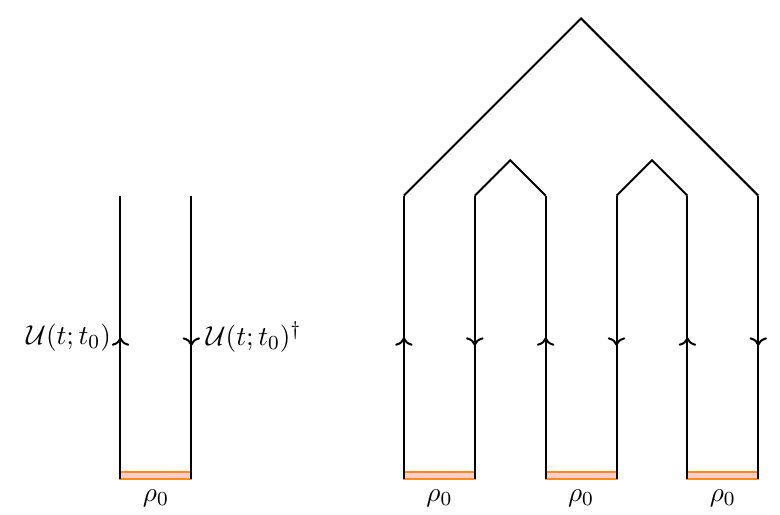
Figure 1 . An illustration of the real-time contours for the computation of the density matrix ρ ( t ) (left) and traces of its powers ( Tr (cid:0) ρ ( t ) 3 (cid:1) on right). The past boundary condition is supplied by the prescribed initial state ρ and the direction of time evolution is explicitly indicated by the 0